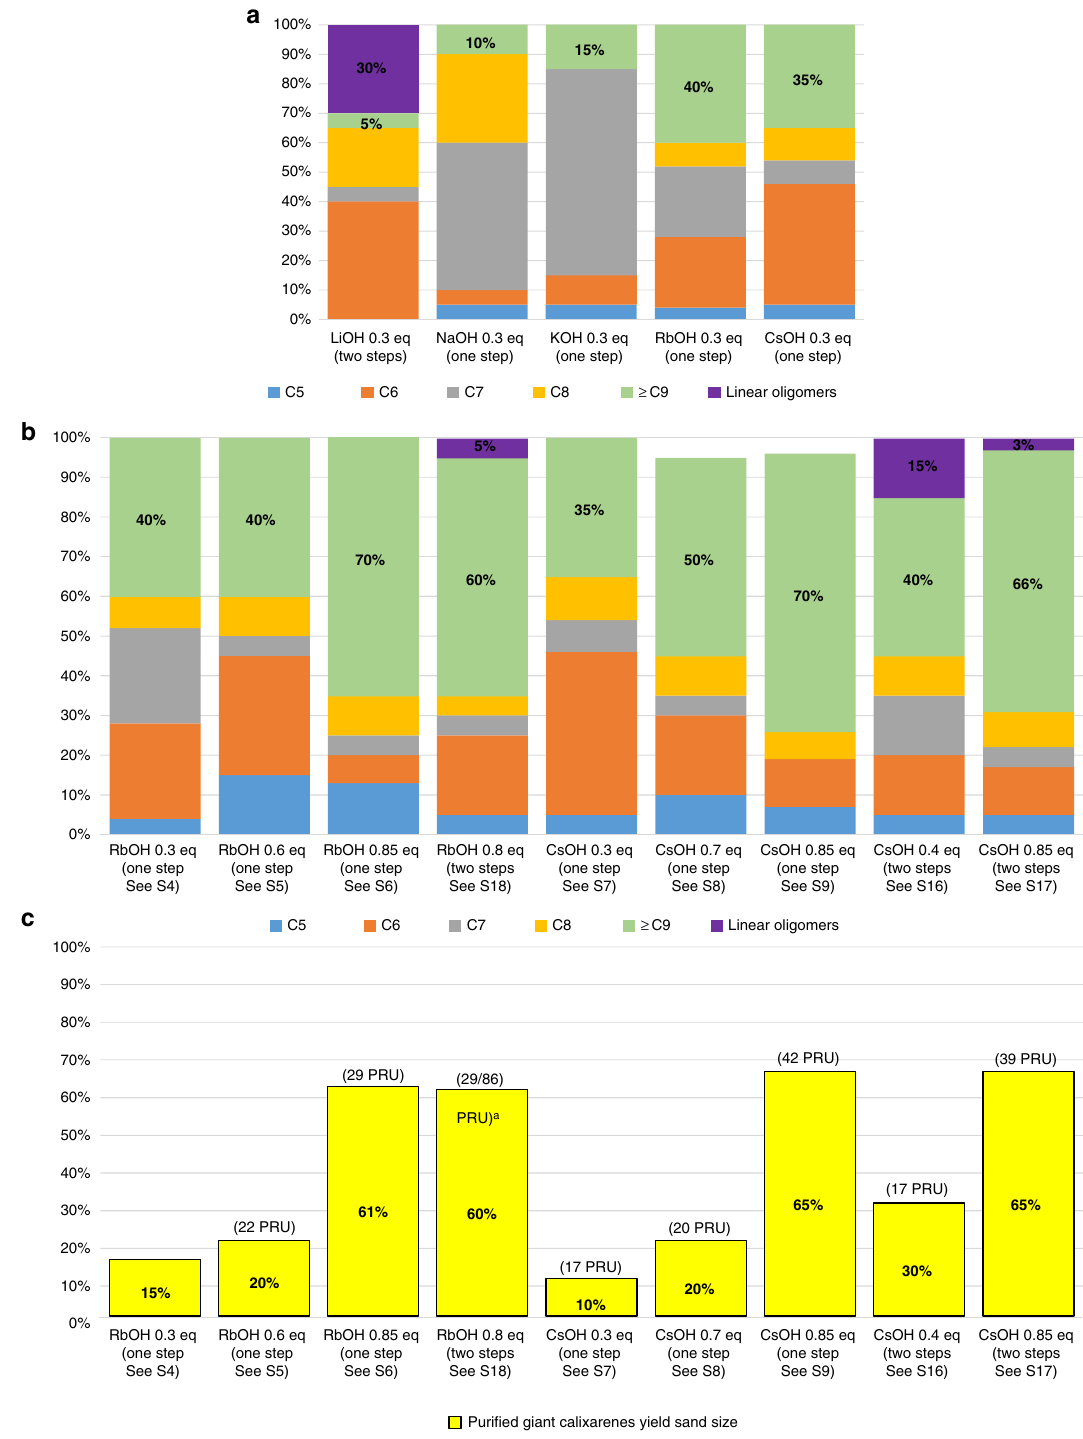
Fig. 9 Yields of the different calixarenes as a function of the reaction parameters. a effect of the base; b effect of CsOH and RbOH/phenol ratio for the one- step and two-steps processes; c yield of puri fi ed giant calixarenes. Sizes expressed as the number of phenolic repetition units (PRU) determined by SEC from the peak molecular weight. a Combined